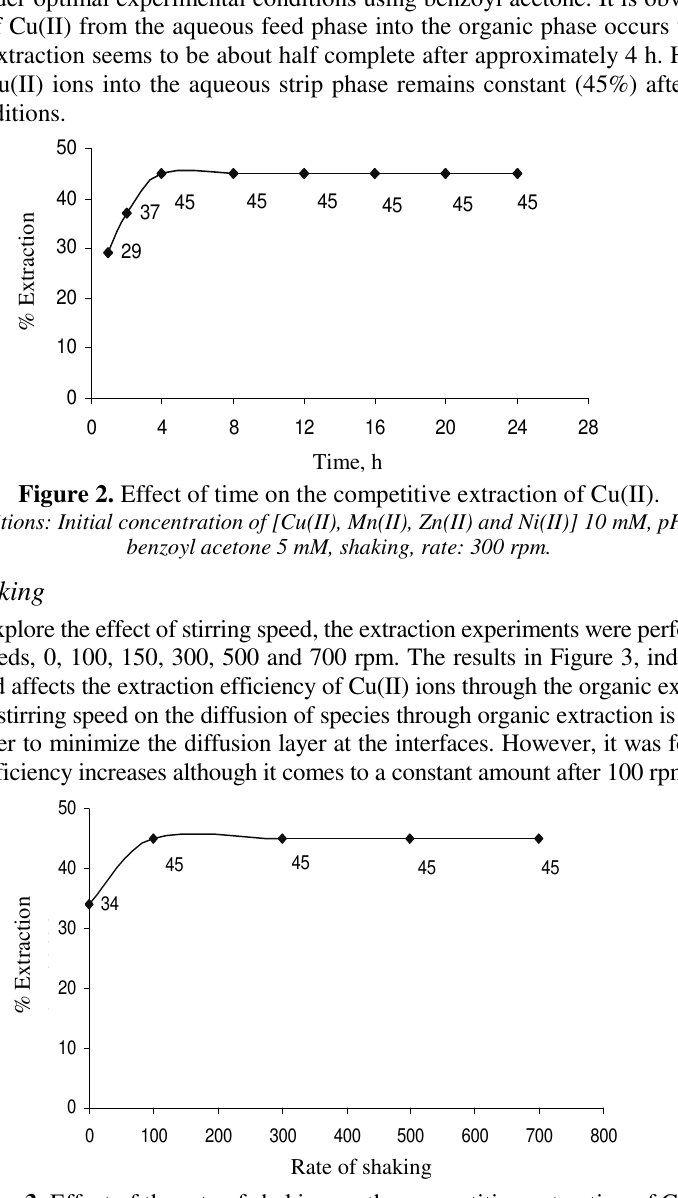
Figure 3. Effect of the rate of shaking on the competitive extraction of